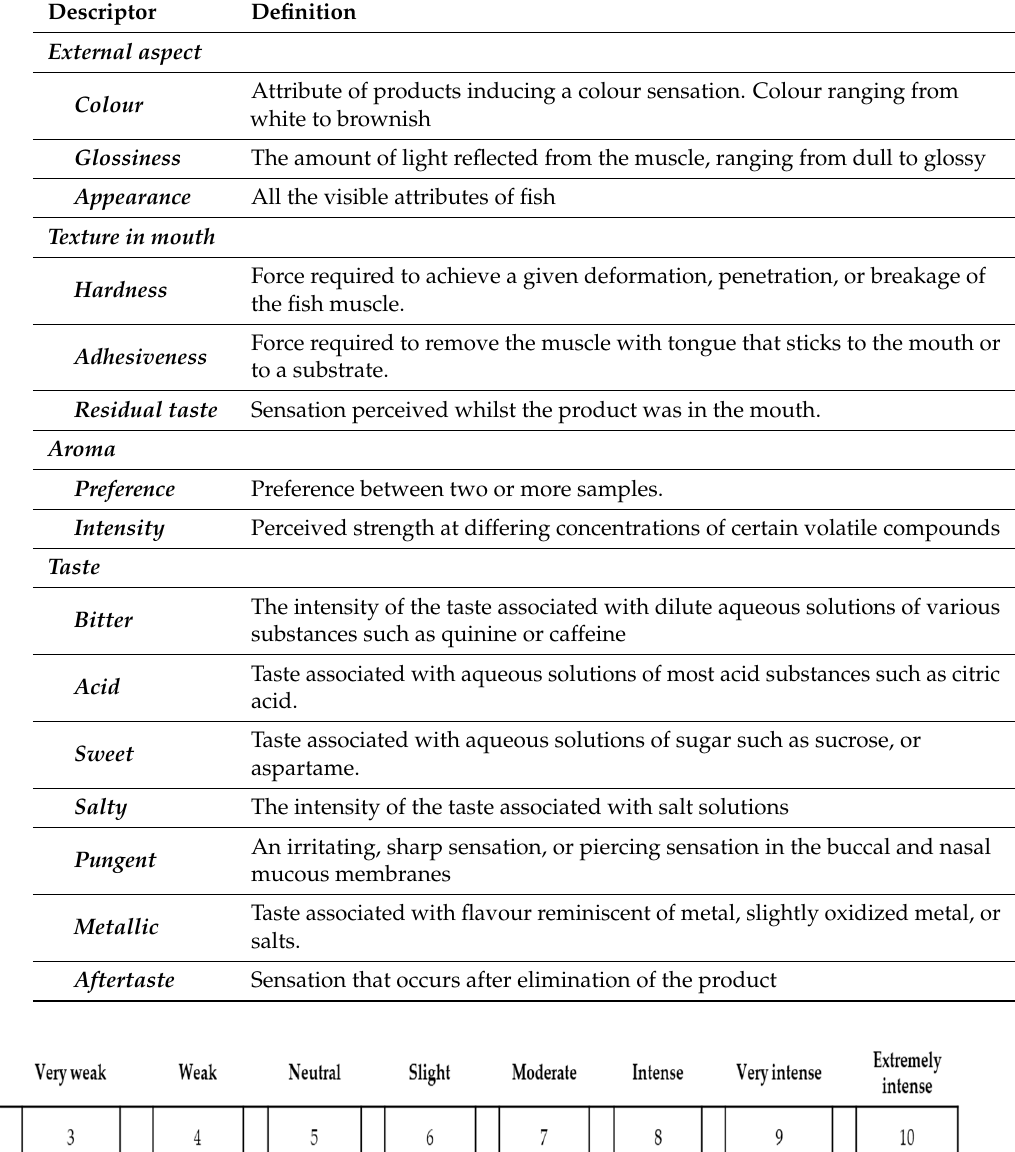
Table 1. Descriptive attributes and their definitions adapted from UNE-EN-ISO 5492:2010.